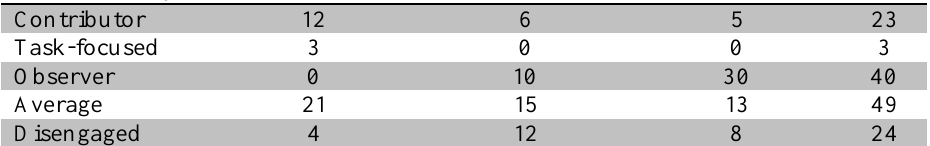
Table 3 Distribution of Learners According to their Interaction Style Interaction style